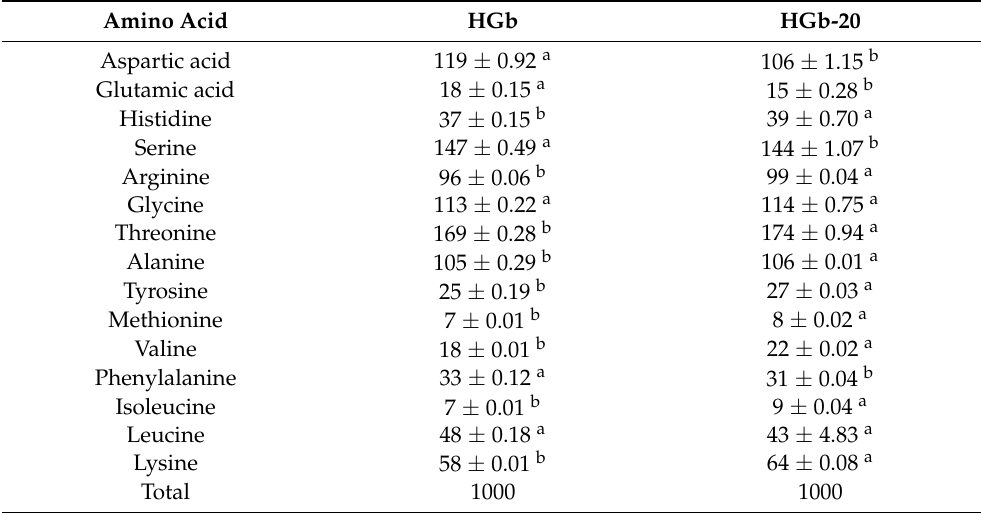
Table 3. Amino acid profile (residues/1000 amino acid residues) of globulin hydrolysates. Amino Acid HGb HGb-20 Aspartic acid 119 ± 0.92 a 106 ± 1.15 b Glutamic